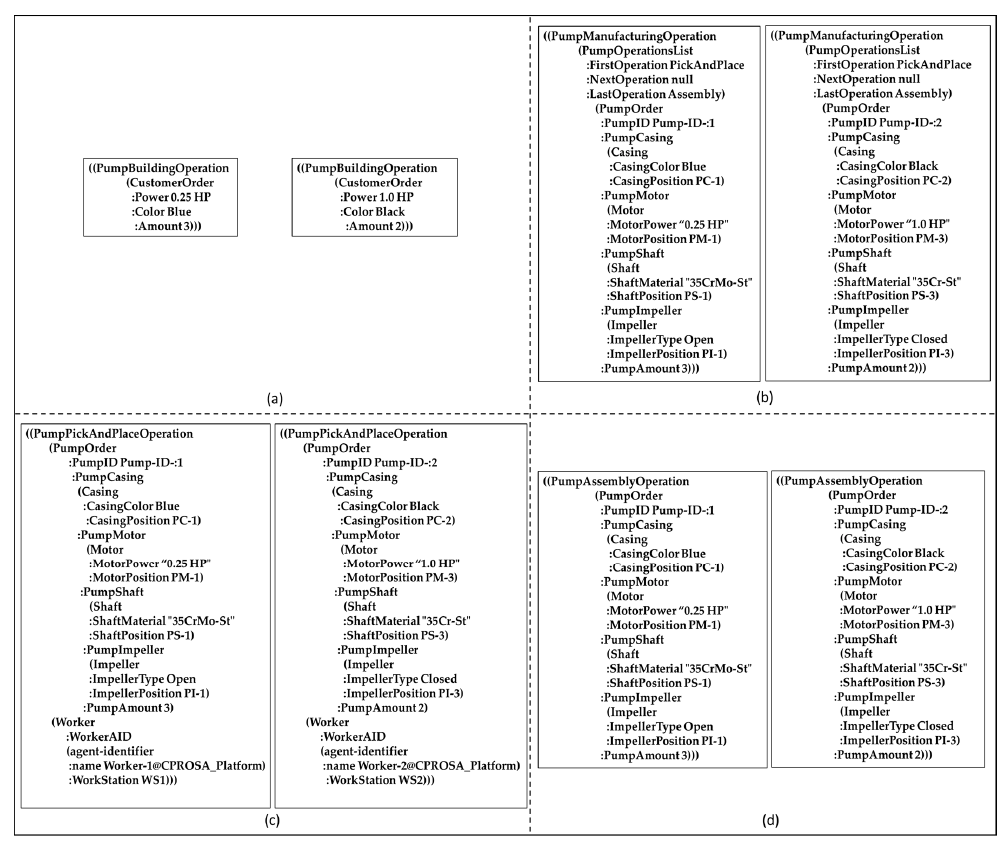
Figure 12. The Contents of the Ontology-Based ACL-Messages during the Case-Study ( a ) Building Operations; ( b ) Manufacturing Operation; ( c ) Pick and Place Operation; ( d ) Assembly Operation.